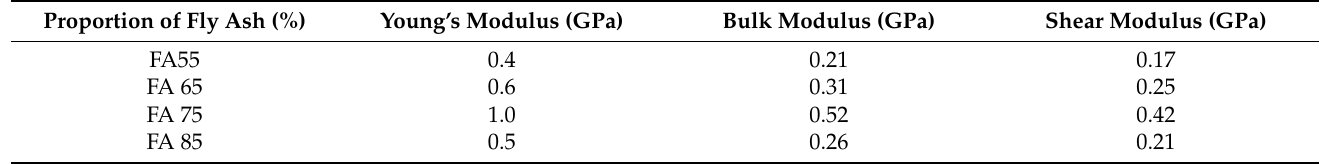
Table 4. The physical and mechanical parameters of CMFB with 14 d curing time and various fly ash